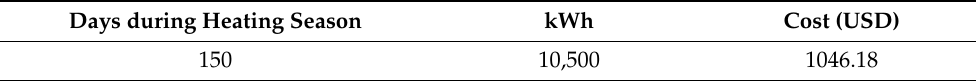
Table 9. Required kWh and heating costs depending on the number of days for a housing unit of 100 m 2 . Days during Heating Season